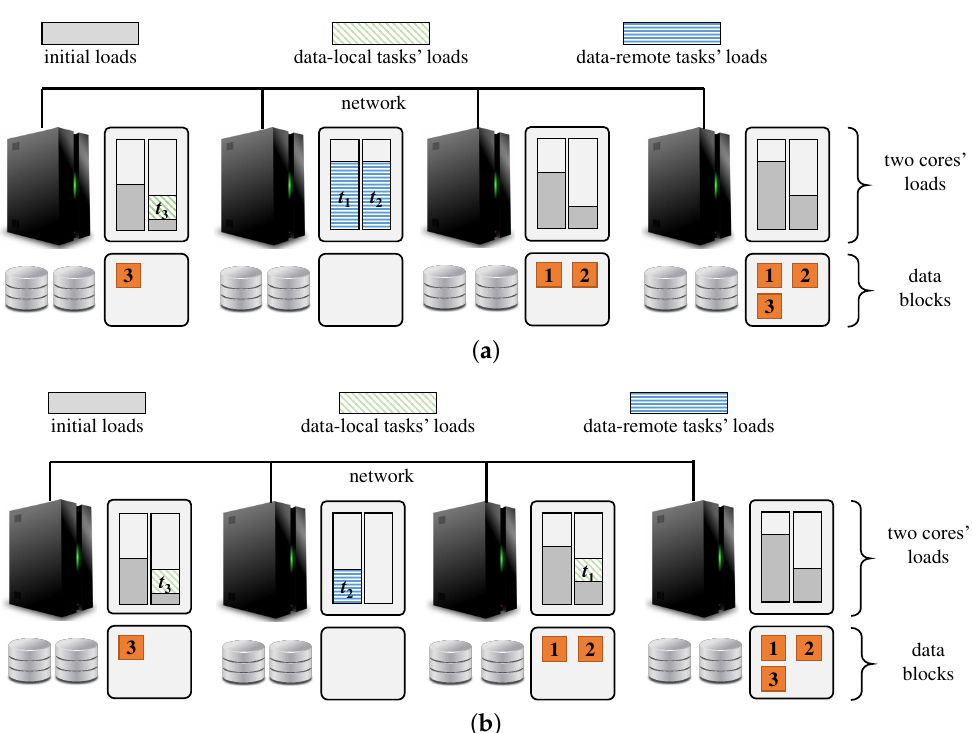
Figure 1. Data-locality-aware task scheduling (task t i processes block i ). ( a ) Hadoop default scheduler’s assignment; ( b ) Optimal